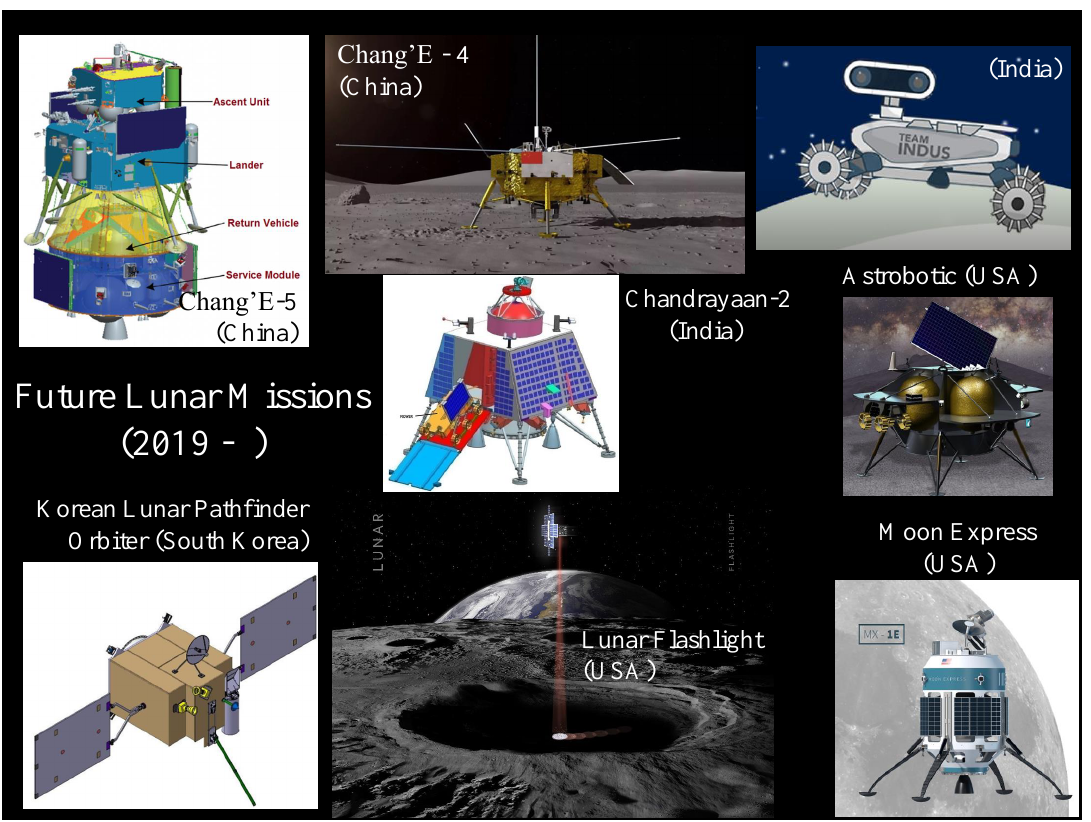
Figure 12. Lunar missions in the near future (planned/proposed). Credits for individual images: CNSA, KARI, NASA, ISRO, Team Indus, Astrobotic and Mars